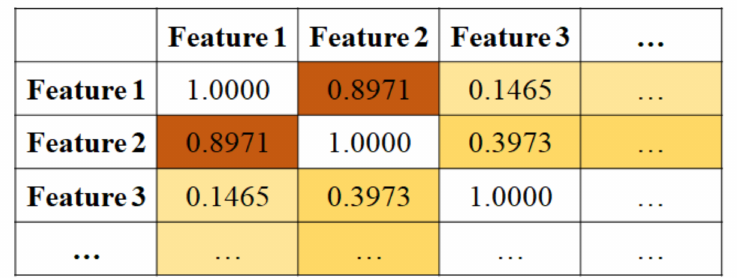
Figure 4. An example of correlation matrix between features.